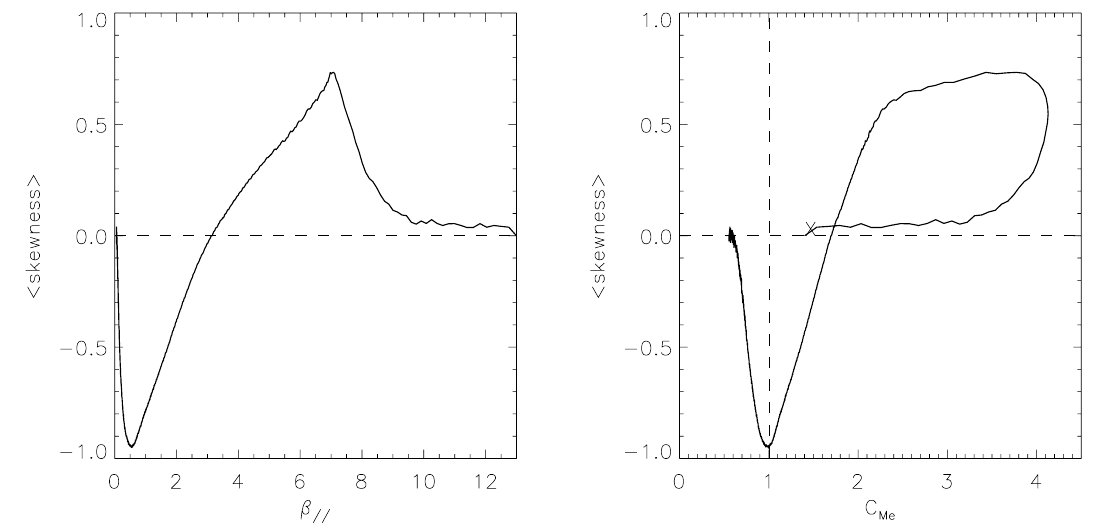
Fig. 9. Results of the HEB simulation code. On the left panel the skewness of parallel magnetic fluctuations as a function of proton β k is displayed. The time evolves from high β k values to lower ones whereas the anisotropy increases, both processes being due to the forced expansion of the plasma box modeled in the code. The transition from positive to negative skewness occurs for β k ’ 3 . 1. On the right panel the skewness is plotted as a function of C Me ( β e = 1) and the starting point of the simulation is referenced by the